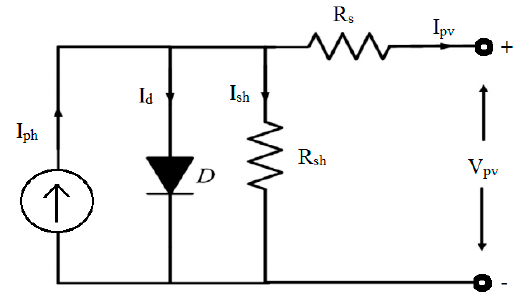
Figure 1. PV Model as single-diode.